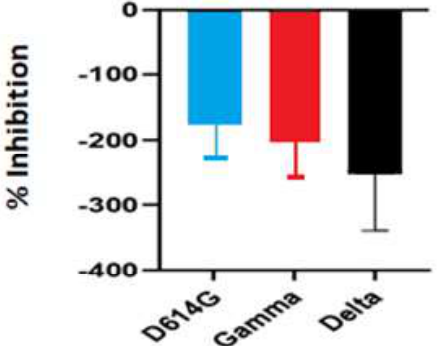
Figure 3. Antiviral activity of Saussurea costus acetic extract against SAR-CoV2. HEK-293T ACE2 cells were infected with the corresponding pseudotyped virus in the presence or absence of the extract. After 48 h, the luciferase activity was measured. The percentage of inhibition was determined as the ratio between treated and untreated cells.